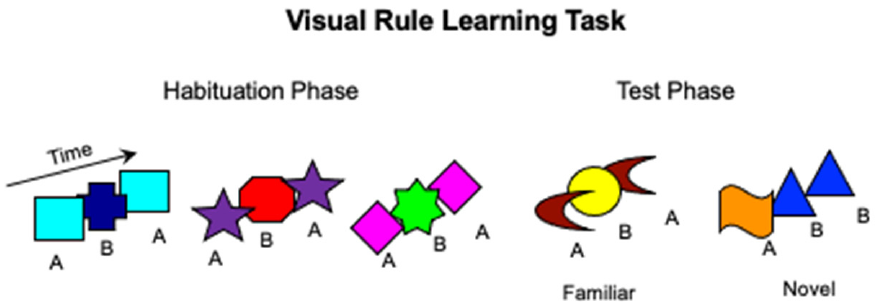
a 500 ms-blank screen was presented before the appearance of the next triplet.